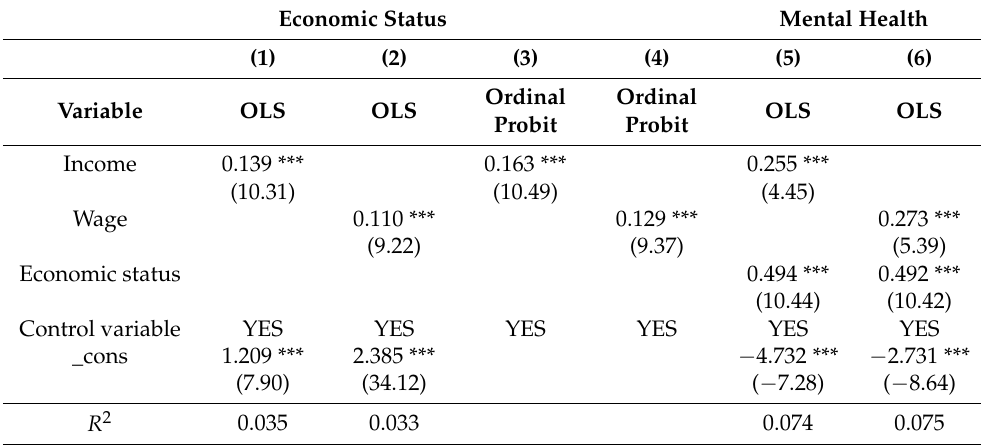
Table 8. With economic status as a mediating variable.